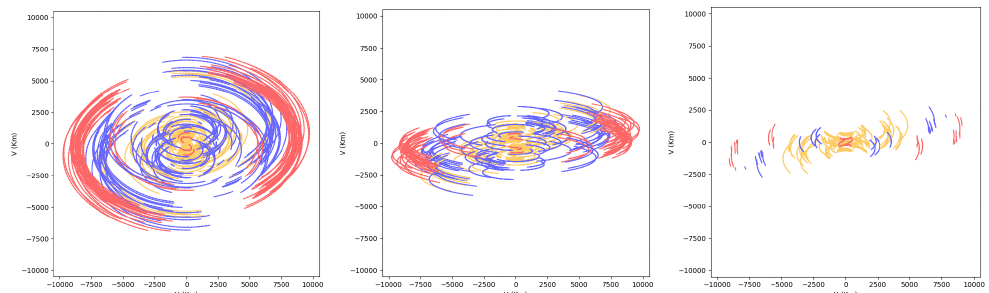
Figure 4. Simulated UV-coverages of EATING VLBI towards sources at declinations of + 40 ◦ , + 12 ◦ and − 30 ◦ , respectively. Curves with orange and red indicate baselines related to EAVN and Ital- ian stations, respectively. Additionally, here we also include 3 Russian stations (Badary, Svetloe, Zelenchuk, with blue-colored curves) that occasionally join EATING VLBI sessions from